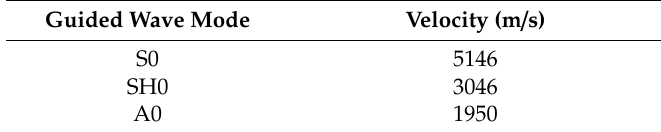
Table 3. Expected velocity of the three guided-wave modes at a frequency of 200